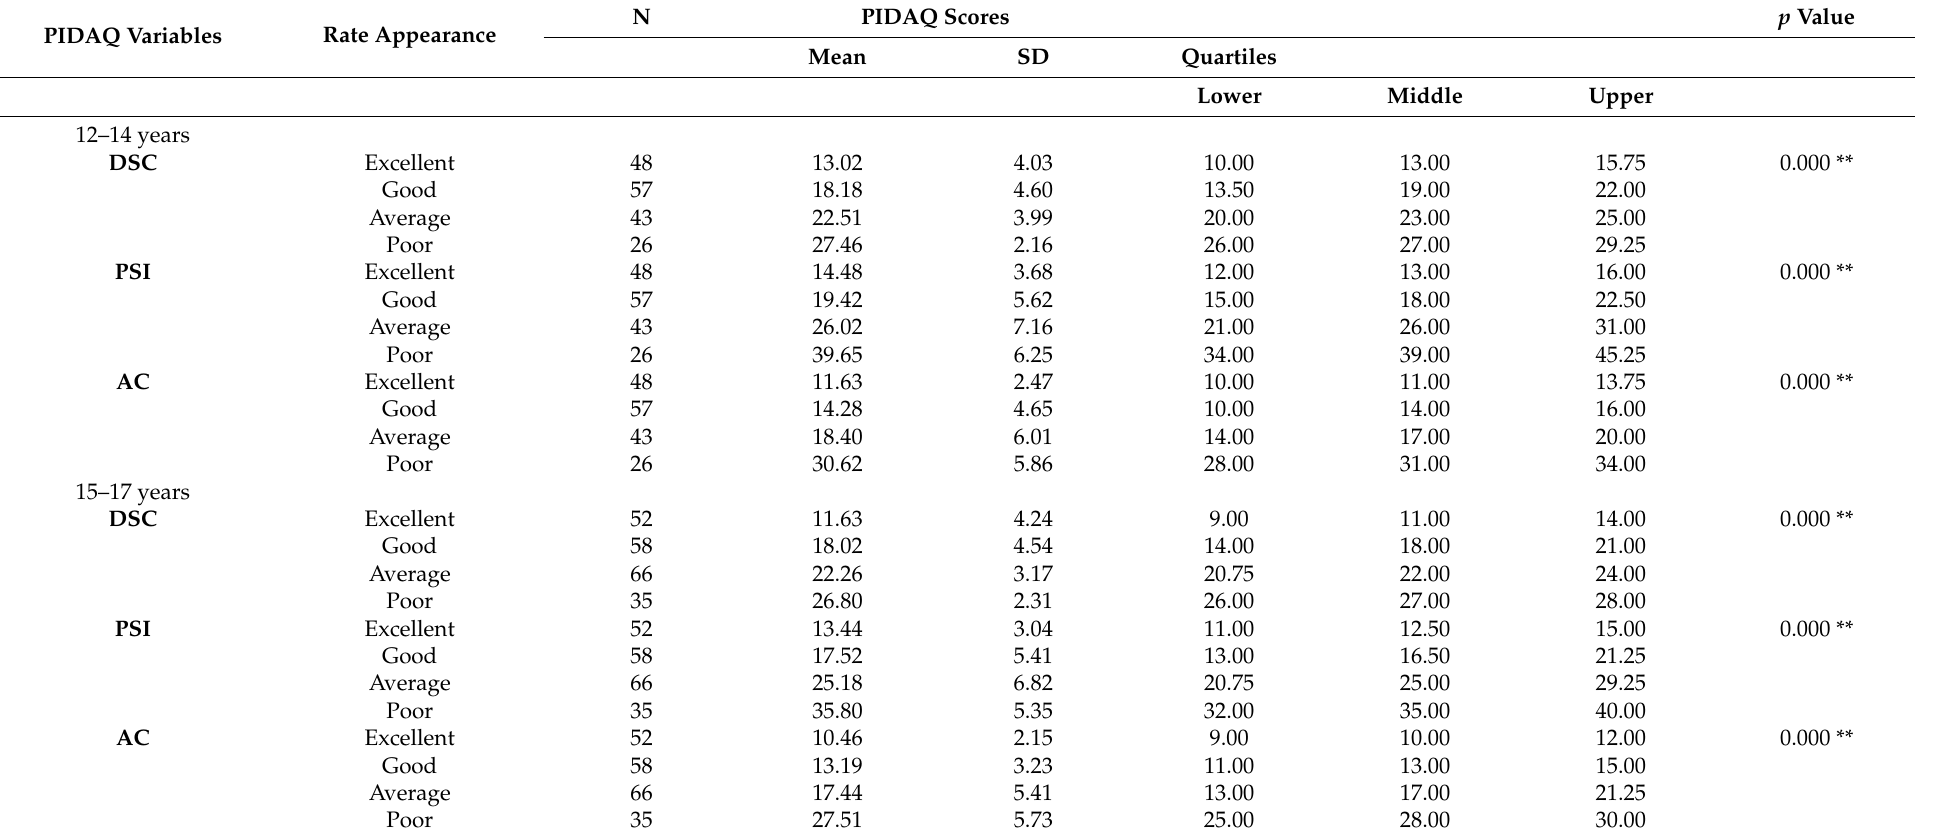
Table 6. Convergent validity: association between the PIDAQ(A) and appearance